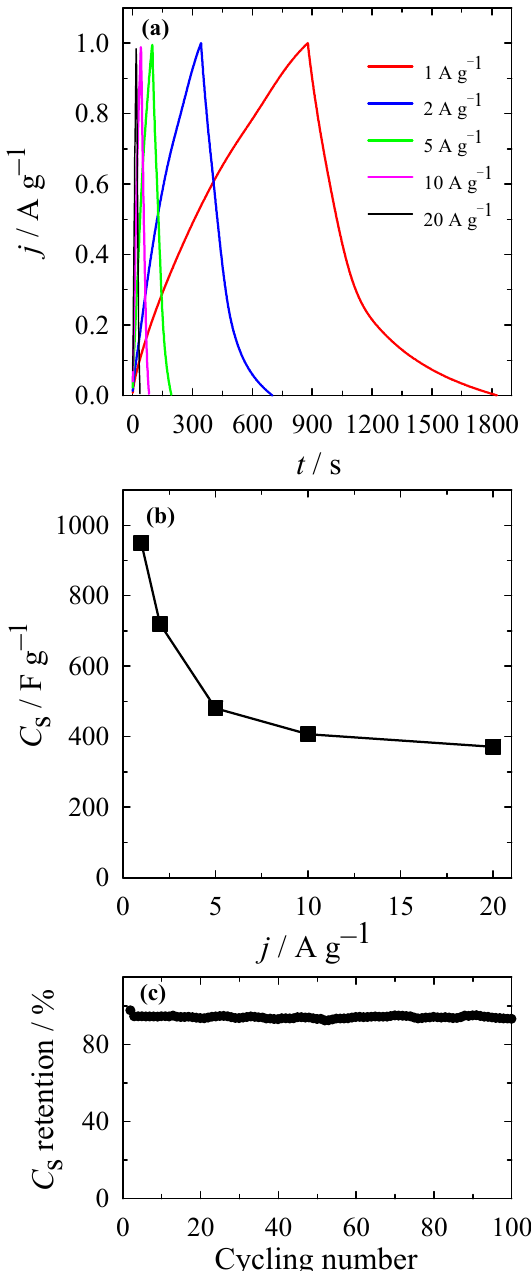
Figure 7. ( a ) Galvanostatic charge/discharge curves of the sample S2 measured at different constant current densities of 1–20 A g − 1 ; ( b ) Specific capacitance obtained from galvanostatic charge/discharge curves with different current densities.